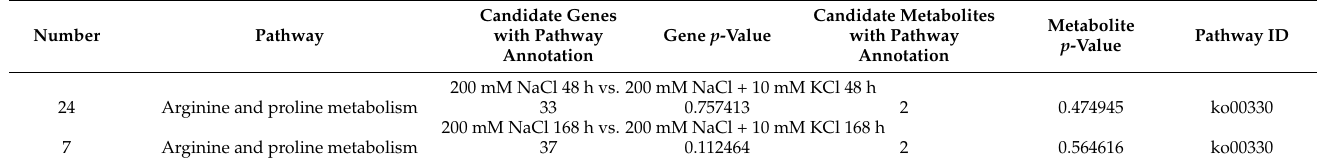
Table 1. Arginine and proline metabolic